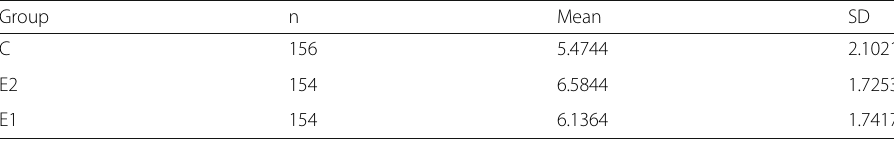
Table 20 The combined mean for Material 3 Group n